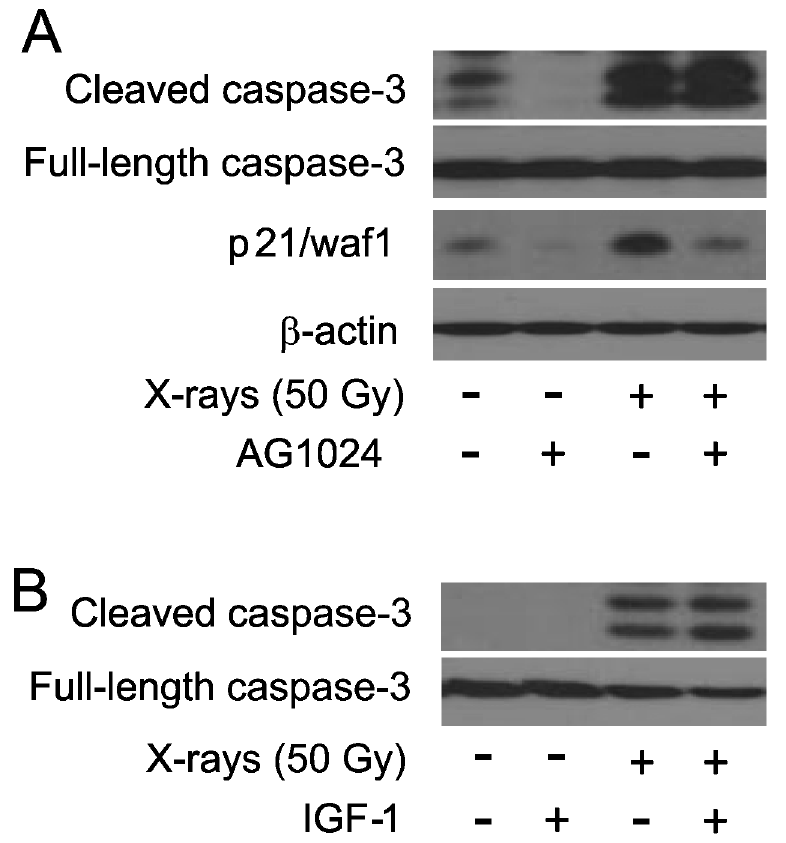
Figure 7. Treatment with AG1024 or addition of IGF-1 does not regulate IR-induced apoptosis. (A) Subconfluent HPAEC were treated with 5 μM AG1024 or DMSO for 30 minutes and subjected to 50 Gy X-rays. At 6 hours post-irradiation, whole cell lysates were prepared and western blotting for cleaved, caspase-3 was performed. (B) Subcofluent cultures of HPAEC were added with 10 × IGF-1 concentration (50 ng/ml) for 18 hours and exposed to 10 Gy X-rays. At 6 hours post-irradiation, whole cell lysates were prepared and western blotting for cleaved, caspase-3 was